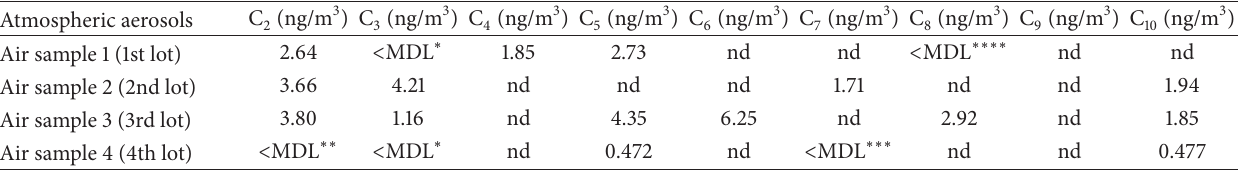
Table 3: DCAs in the aerosol samples studied. Samples were pretreated following the optimized concept informed in the experimental. Separation conditions as in Table